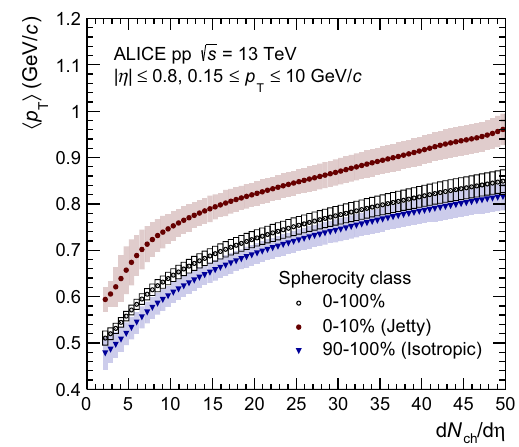
Fig. 7 Average transverse momentum as a function of event multiplic- √ s = 13TeV.Resultsforthespherocity-integrated ityinppcollisionsat case (0–100%) are contrasted with the measurements for the most jet- like (0–10%) and isotropic (90–100%) events. Statistical uncertainties (error bars) are negligible compared to systematic uncertainties (boxes around the data points)